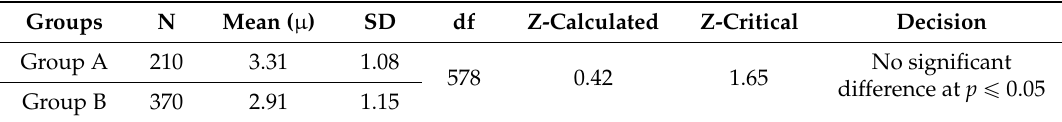
Table 4. Test of significant difference in mean students’ perceived stress behaviour scores affecting learning in LTH-2 and